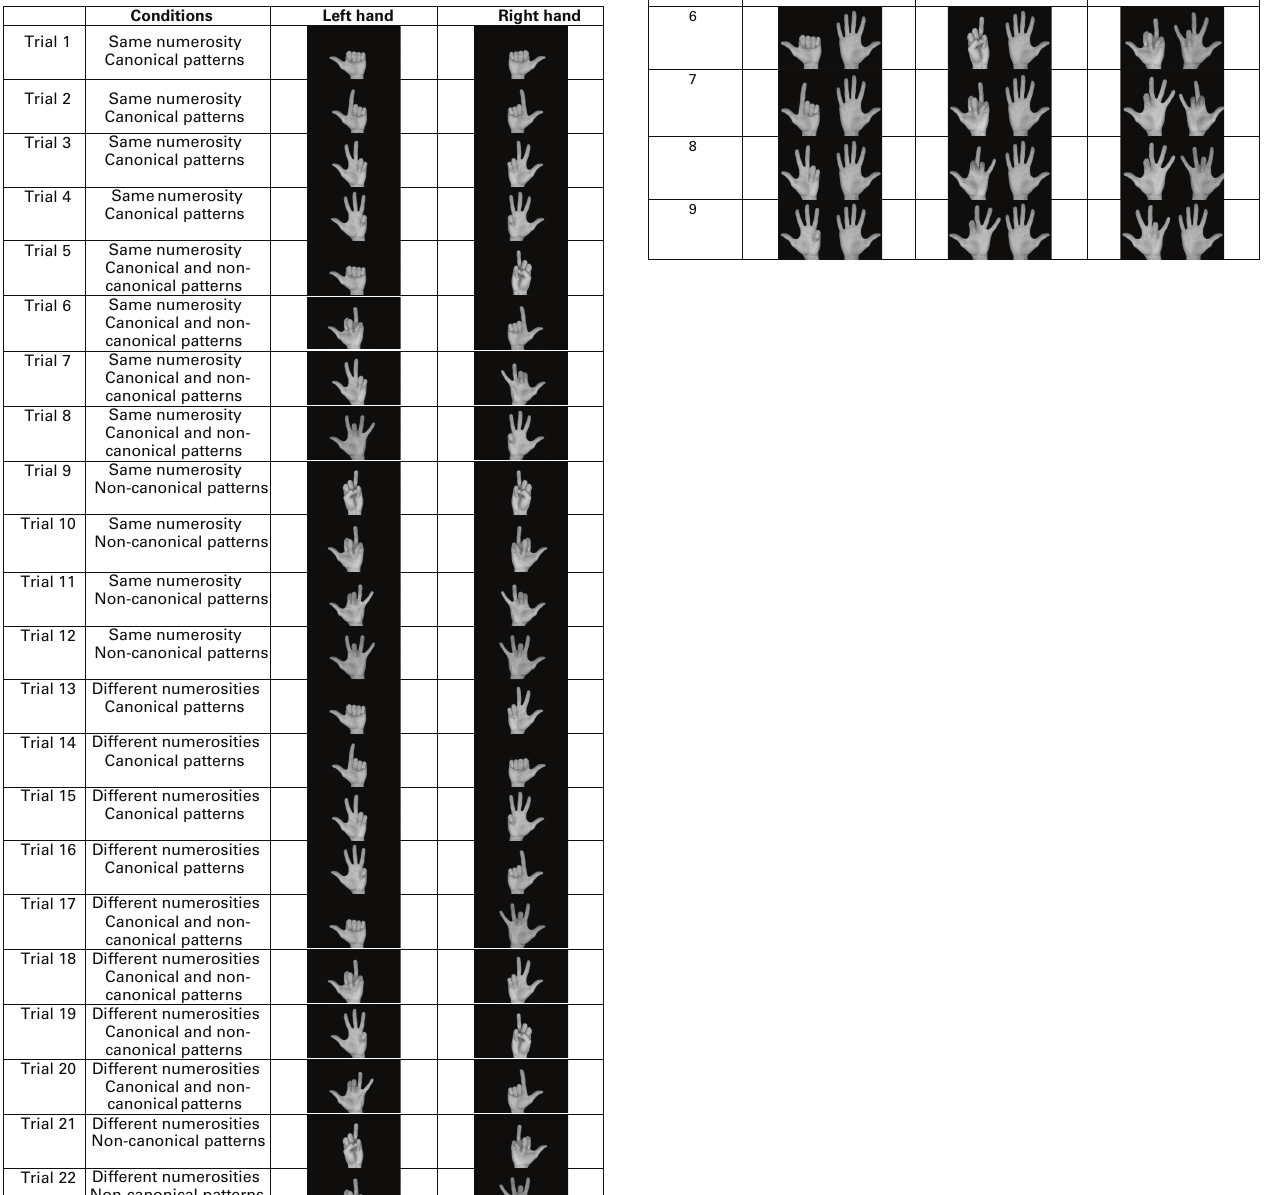
Table A1 | List of the 24 trials presented in the comparison of finger numerical pattern (adapted from Noël, 2005 and Gracia-Bafalluy and Noël, 2008).